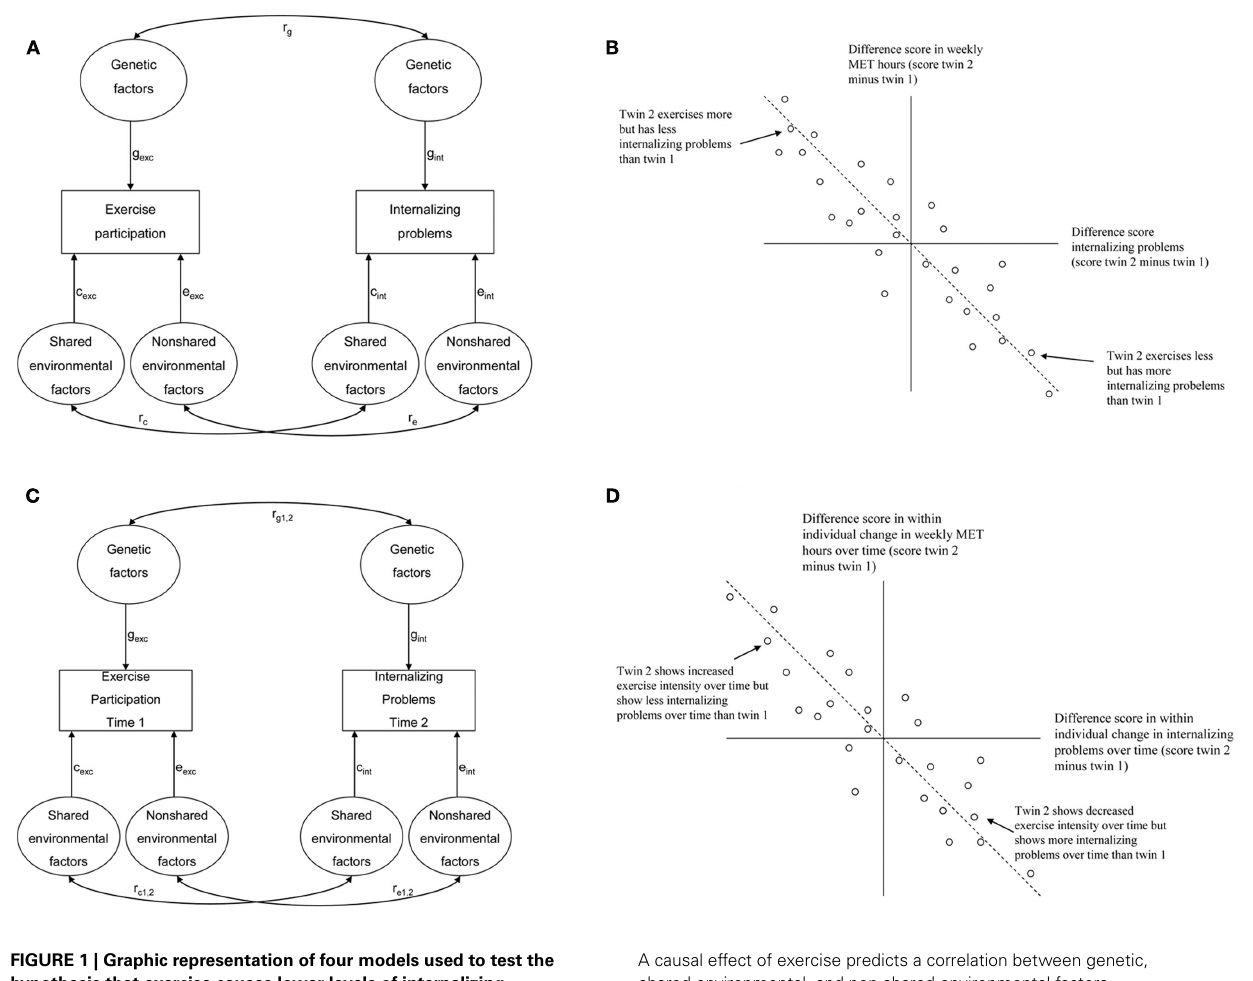
FIGURE 1 | Graphic representation of four models used to test the hypothesis that exercise causes lower levels of internalizing problems. (A) A causal effect of exercise predicts a correlation between genetic, shared environmental, and non-shared environmental factors influencing exercise behavior and internalizing problems. Cross-sectional correlation between exercise and internalizing problems = ( g exc × r g × g int ) + ( c exc × r c × c int ) + ( e exc × r e × e int ). (B) A causal effect of exercise predicts that in genetically identical twins, the